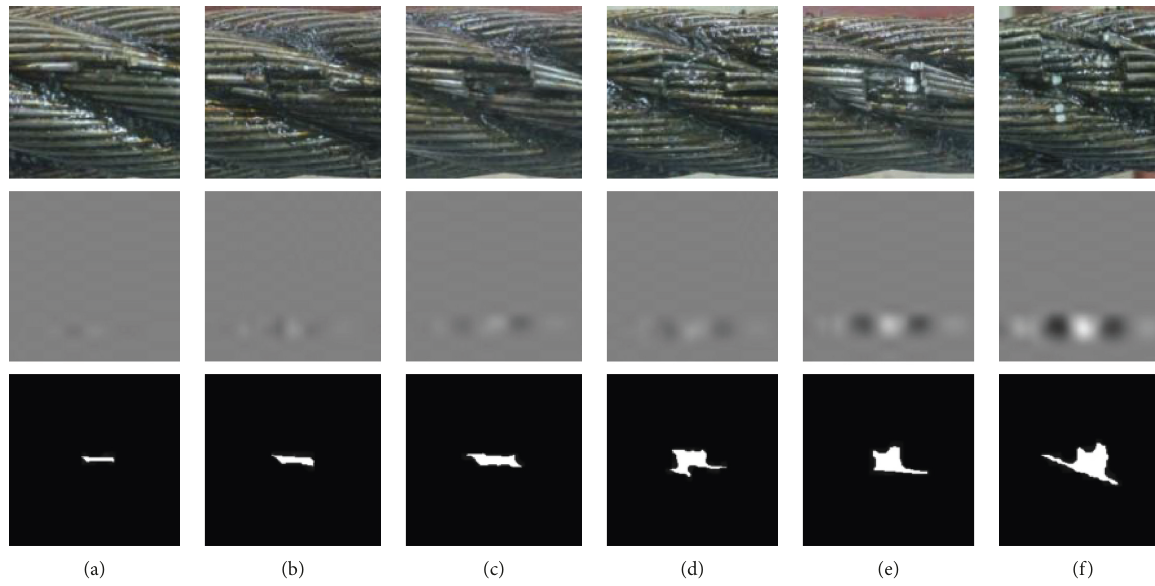
Figure 12: Photos (above), MFL grayscale images (middle), and infrared binary images (below) of 6 different defects: (a) one broken wire; (b) two broken wires; (c) three broken wires; (d) four broken wires; (e) five broken wires; (f) seven broken